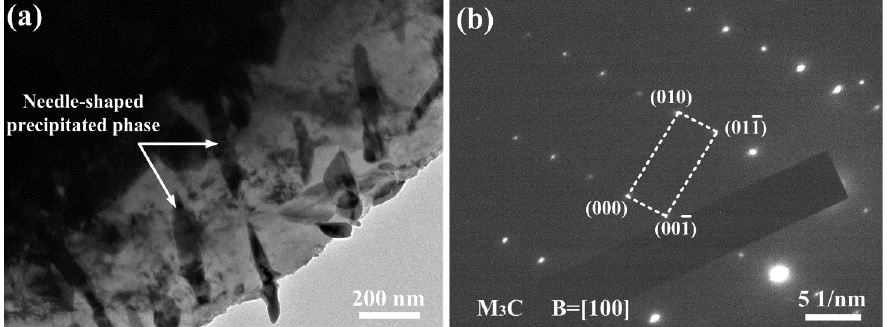
Figure 7. Microstructures of BM-1 and HAZ-1 obtained by OM and SEM. ( a ) Overall micrograph of HAZ-1. ( b ) OM micrograph of BM-1. ( c ) OM micrograph of FGZ in HAZ-1. ( d ) SEM micrograph of BM-1. ( e ) SEM micrograph of FGZ in HAZ-1.